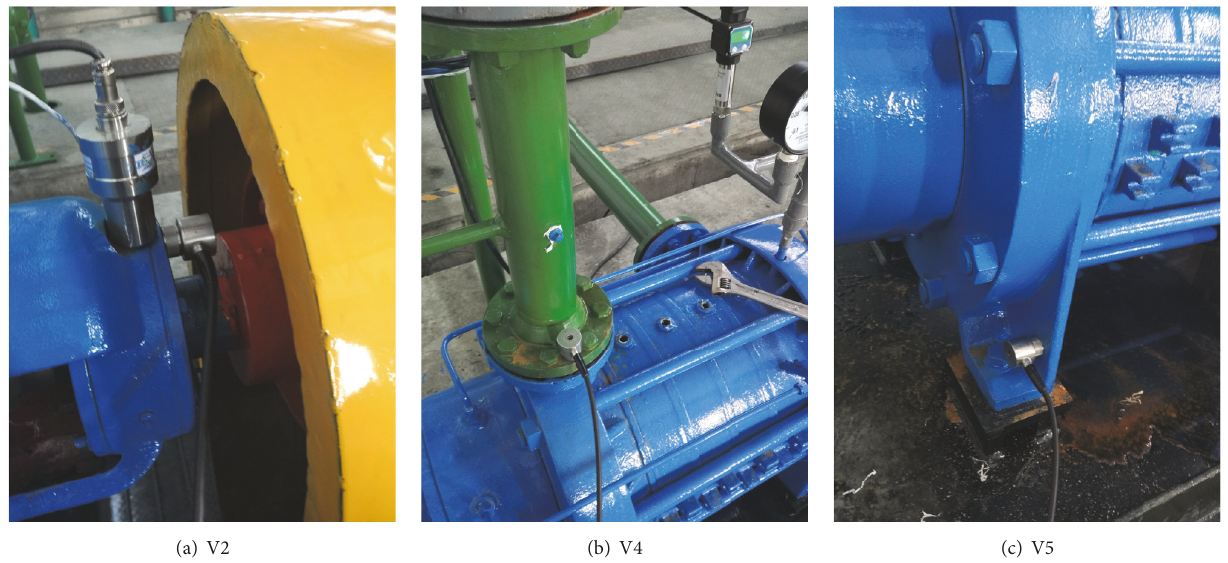
Figure 4: Location of vibration monitoring